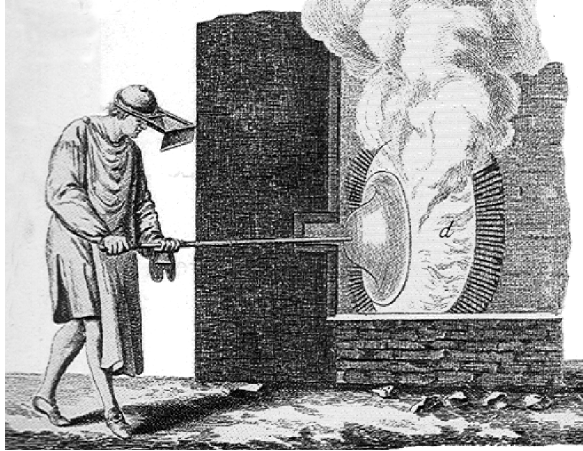
Figure 1: Flat glass as made by the crown process from a vessel that is first blown and then opened and flattened, opposite to the blowing pipe side, through rotation in front of a very hot furnace (engraving from the 18th-century Encyclopédie of Diderot and D’Alembert). In the mantle process, a large cylinder is first blown, cut at both ends and then along one side, and finally opened and flattened in a furnace heated near the softening